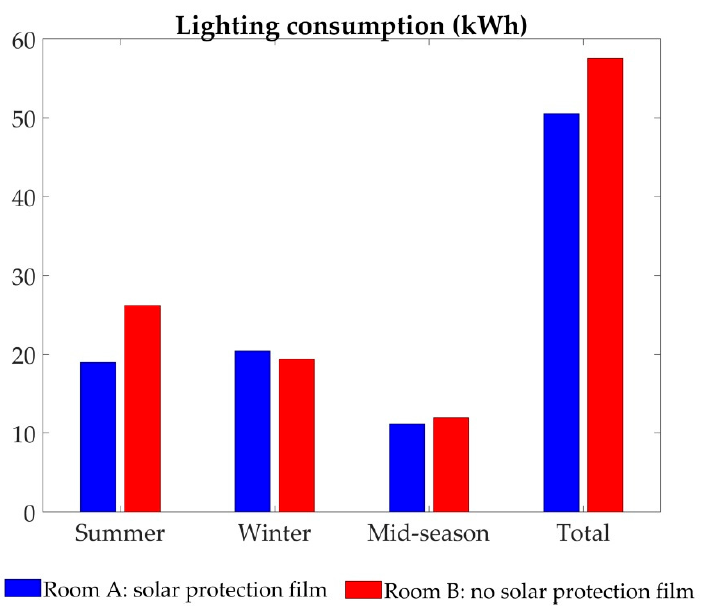
Figure 9. Electric consumption of the artificial lighting system (kWh) in each seasonal period and total saving value obtained. Source: Authors.